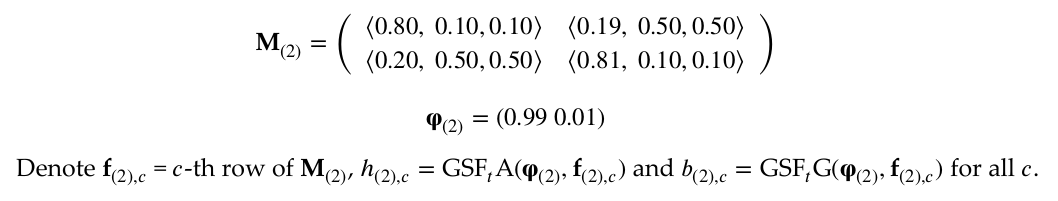
𝑡 A and GSF 𝑡 A for compliance of Test